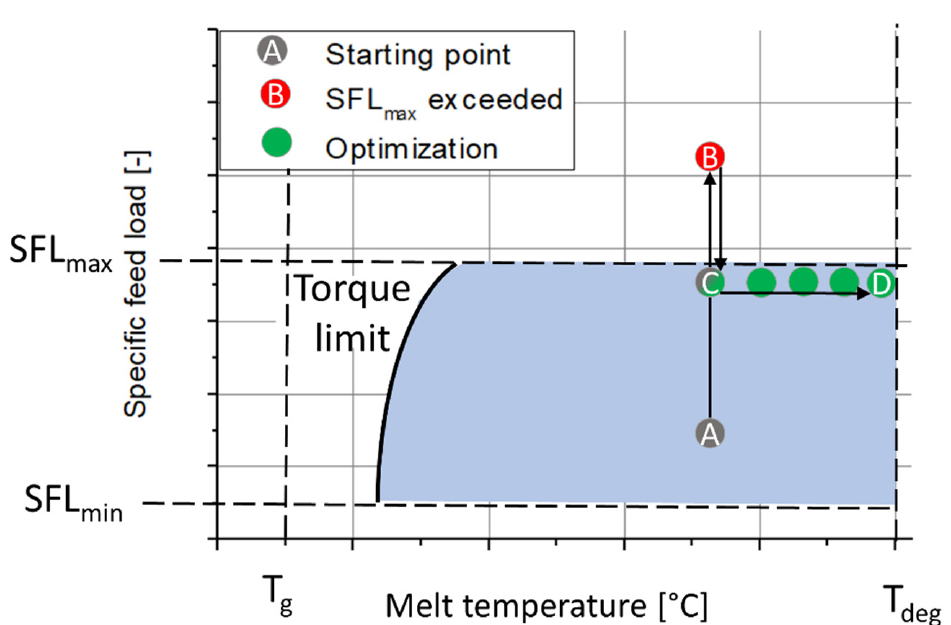
Figure 2. Schematic presentation of the SIOS. The resulting operating window is depicted in blue (according to [14]).